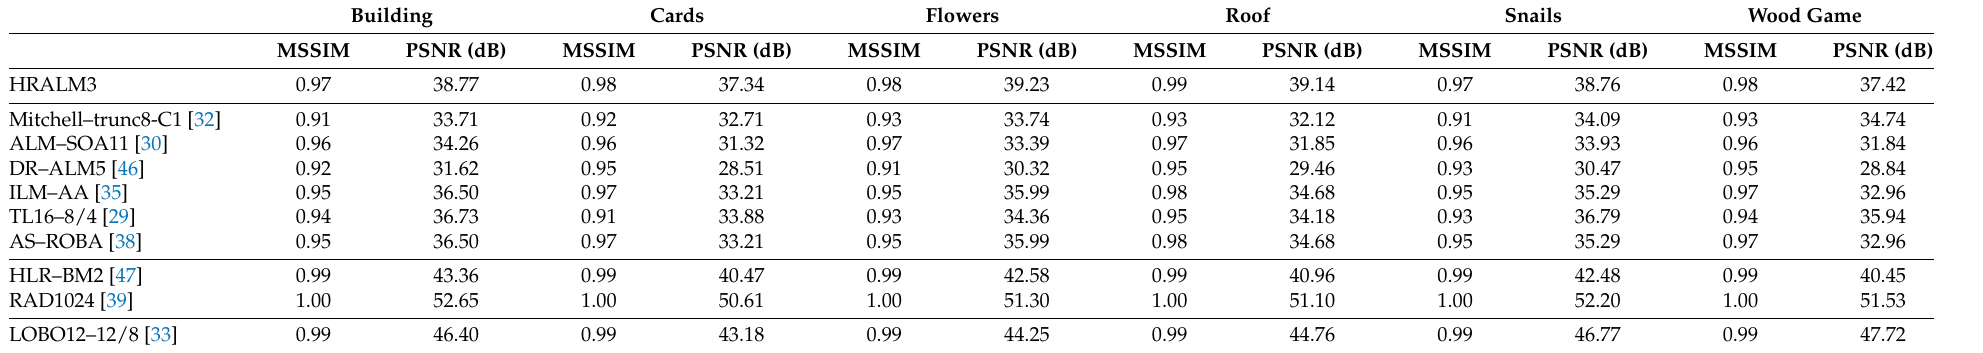
Table 5. The MSSIM and PSNR metrics for lossy image compression for the quality factor F =